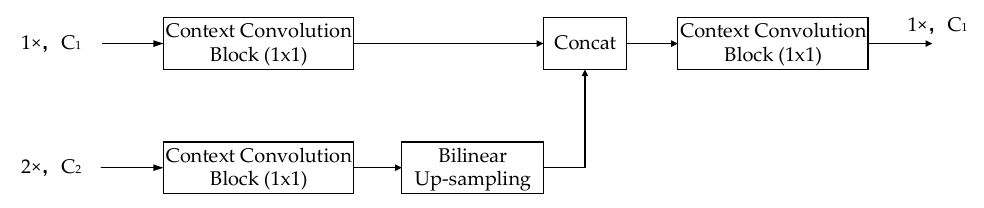
Figure 4. The joint context up-sampling block.